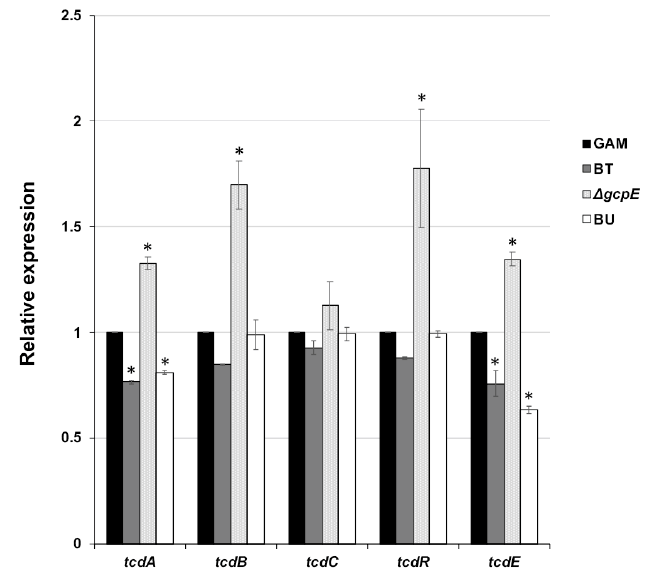
Figure 5. Effect of BT-derived PFs on PaLoc gene expression. After CD was cultured to late-logarithmic phase in the conditioned medium containing 2.0 mg/mL PFs from the indicated strains, the RNA was extracted from each sample. RT-qPCR was performed to examine the change in gene expression for toxins A and B ( tcdA and tcdB ), the positive- and negative-regulators ( tcdR and tcdC ), and the holin-like protein ( tcdE ). The relative expression of each gene to the control (expression in the conditioned medium prepared with PF from GAM broth) is shown. Significant difference compared with GAM is indicated by * ( p < 0.01).